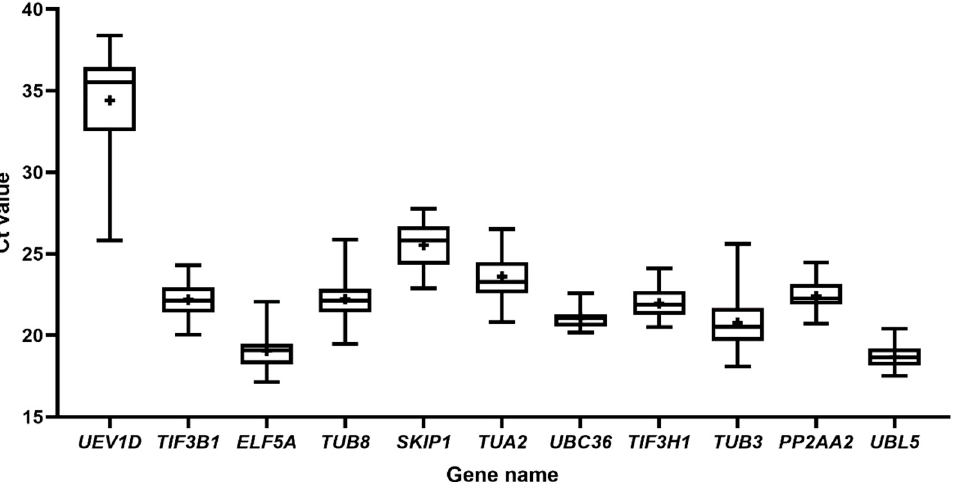
Figure 1. Candidate reference gene expression levels across all samples. The boxes depict the interquartile range. Hyphens above and under the boxes denote the maximum and minimum values, respectively. The median is represented by the line that runs across the box. The mean values are shown by the plus sign in the box. Three technical and biological replicates were carried out in RT- qPCR.